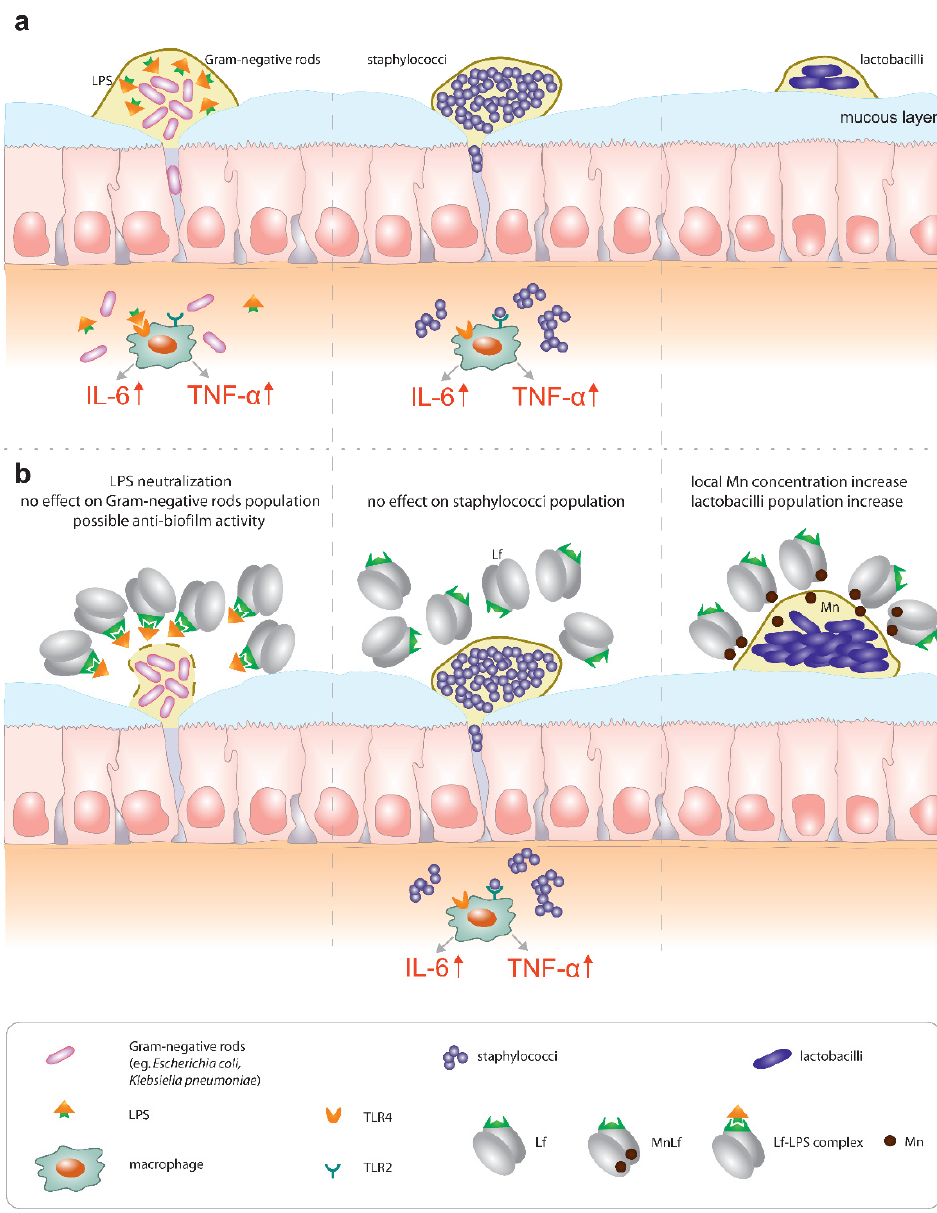
Figure 7. Potential activity of lactoferrin towards Gram-negative rods (left panel), staphylococci (middle panel) and lactobacilli (right panel). ( a ) In the absence of lactoferrin, both Gram-negative rods ( Escherichia, Klebsiella ) and staphylococci readily translocated through the intestinal lumen and induced an inflammatory response via toll-like receptor (TLR) signaling. Population numbers of probiotic bacteria of the Lactobacillus genus were not sufficient for gut colonization. ( b ) In the presence of lactoferrin, the population of Gram-negatives was slightly decreased potentially due to the inhibition of biofilm formation. The Staphylococci population was not affected by the presence of lactoferrin. Lactobacillus population numbers increased due to manganese release from MnLf.